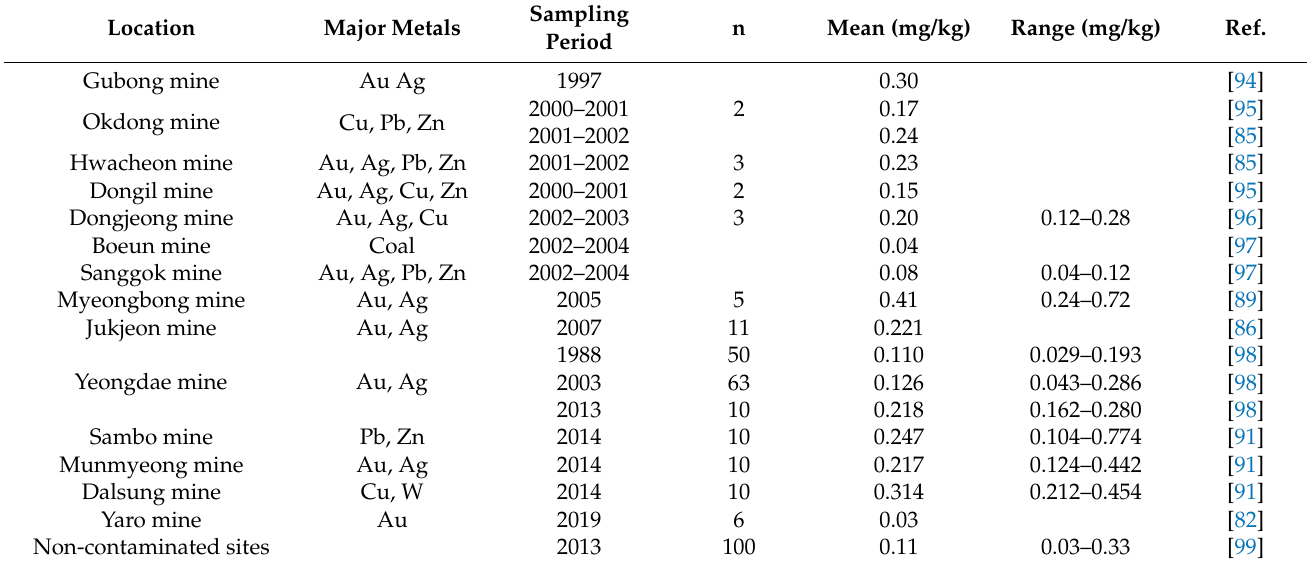
Table 6. Total arsenic concentration in polished rice sampled from mining sites in